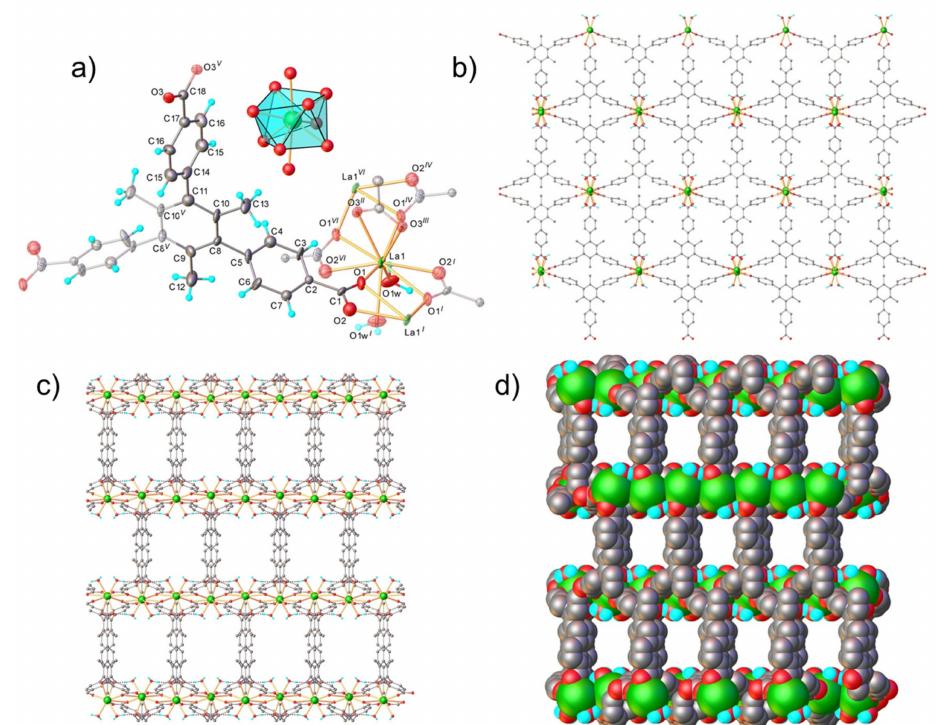
Figure 2. Crystal structure of compound [LaL(H 2 O) 2 ] n ( 1 ). Extended view of the asymmetric part and coordination environment around La in 1 along with the atom labelling scheme and thermal ellipsoids at the 40% probability level. Symmetry generated fragments are drawn with 50% transparency ( a ). Crystal structure packing viewed along the a axis ( b ). View of the crystal structure showing formation of the channels along the b axis ( c ). Space filling representation for ( d ). Symmetry codes: I = 1 − x , 1 − y , 1 − z ; II = 1.5 − x , 0.5 + y , 0.5 − z ; III = x , 0.5 − y , 0.5 − z ; IV = 2 − x , 1 − y , 1 − z ; V = 1.5 − x , − y , z ; 0.5 + x , y , 1 − z